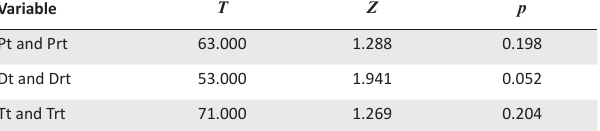
TABLE 5a: The Wilcoxon matched pairs hypothesis tests comparing test and retest measurements for 20 right eyes for the protan, deutan and tritan vectors of the Trivector test (see Figure